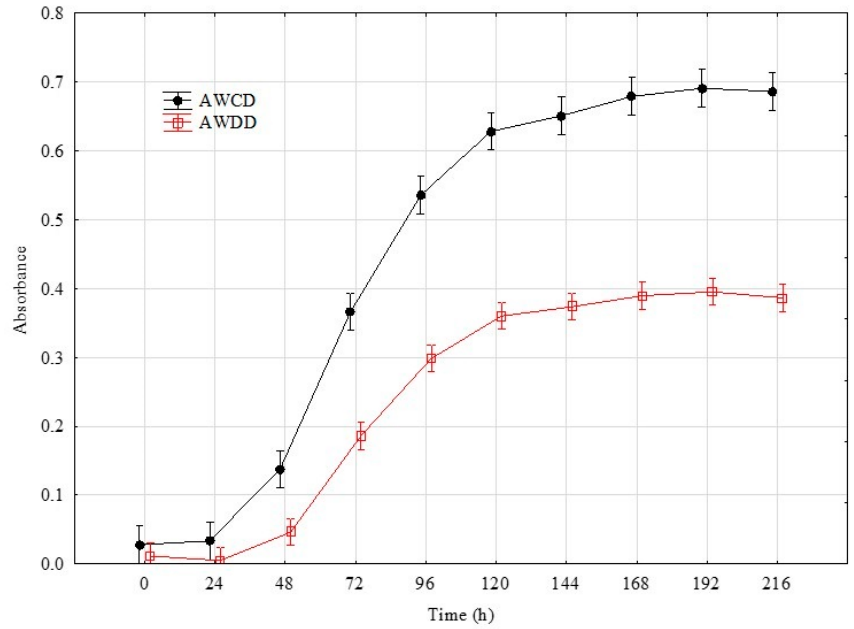
Figure 1. Changes in total AWCD and AWDD values calculated on the basis of the pathogenic fungi and beneficial Trichoderma isolates’ response to Filamentous Fungi (FF) Biolog ® substrates. Definitions: AWCD—Average Well Colour Development (A 490nm ), AWDD—Average Well Density Development (A 750nm ) ( n = 3).